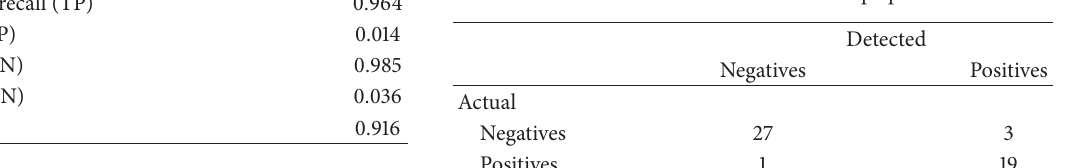
Table 8: The resultant confusion matrix for palpation